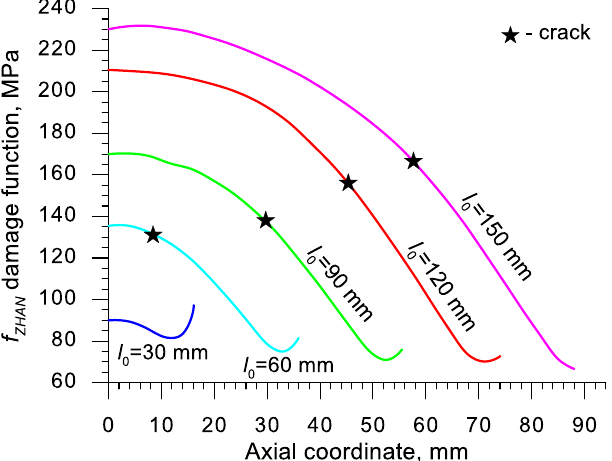
Figure 27. Distributions of the damage function in the axis of a rotationally compressed sample, determined on the basis of the Zhan et al. criterion.